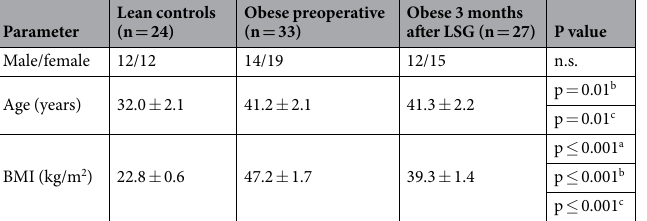
Table 2. Baseline demographics in (Group 2) morbidly obese patients pre- and 3 months post-LSG and lean controls. Data represent means ± SEM; p-value: a pre versus post-surgery, b non-operated obese vs. lean, c obese post-surgery vs. lean, using a Student’s paired t